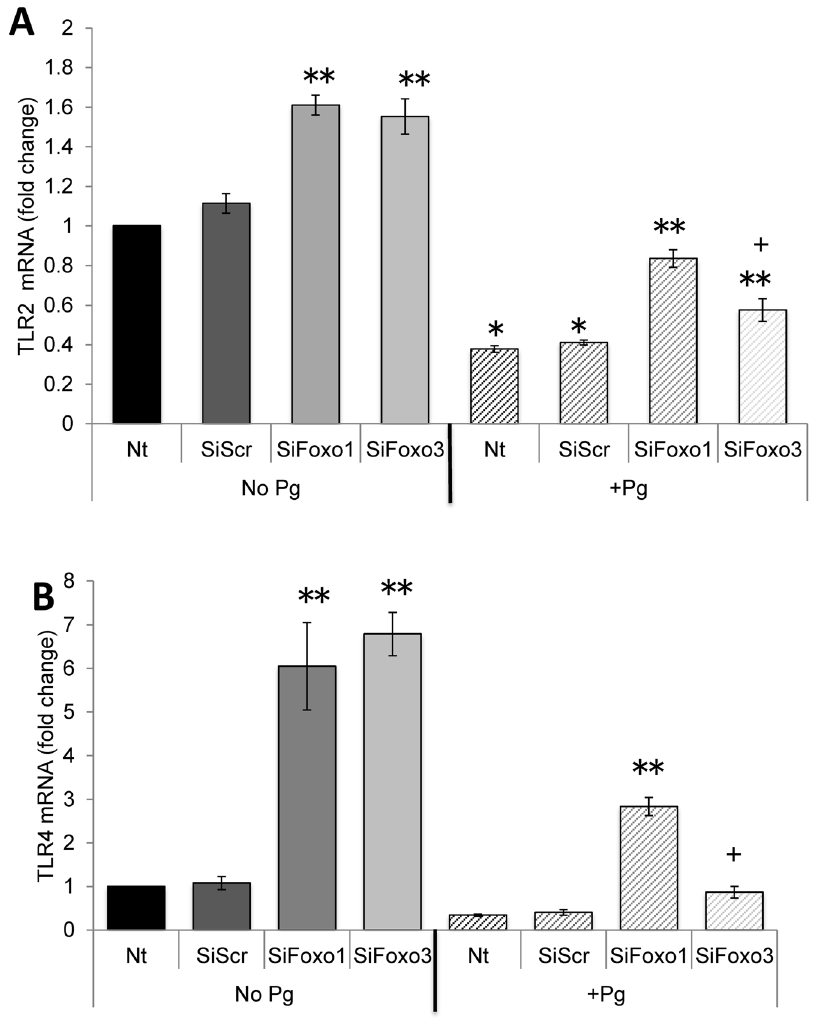
Figure 7. FOXO1 and FOXO3 regulate basal and P.gingivalis up-regulated mRNA levels of TLR2 and TLR4. Primary human gingival epithelial cell cultures were incubated with or without P. gingivalis at MOI=1:50 for 20 hrs. In some cases cells were pre-incubated with FOXO1 siRNA (SiFOXO1), FOXO3 siRNA (SiFOXO3) or scrambled siRNA (SiScr) FOXO1 prior to stimulation with bacteria. Real-time PCR was used to measure mRNA levels of TLR-2 and TLR-4. * Significantly different from control cells without bacterial stimulation (P , 0.05). ** Significantly different between scrambled siRNA and FOXO1 or FOXO3 siRNA (P , 0.05). + Significantly different between FOXO1 siRNA and FOXO3 siRNA (P , 0.05).